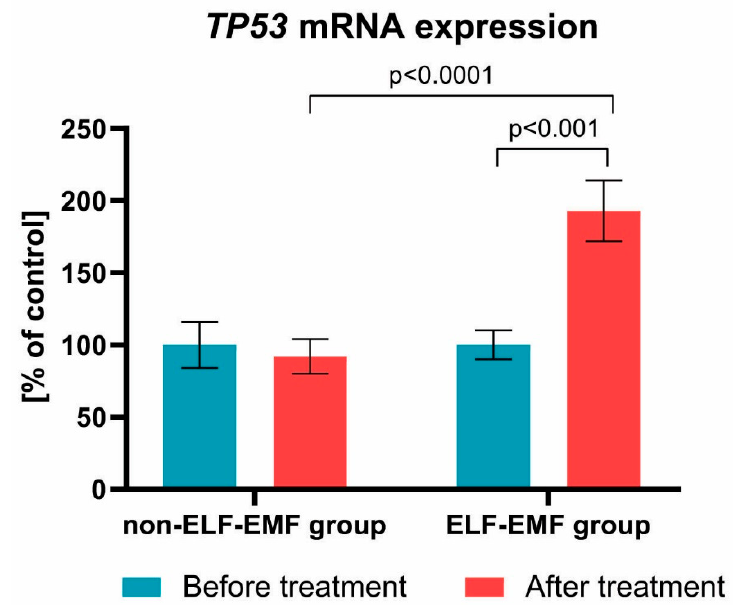
Figure 6. Comparison of the TP53 mRNA expression acquired from the ELF-EMF group vs. the non-ELF-EMF group. Results formulated as parameter changes before and after therapy (100% expressed for the level of TP53 mRNA expression in each patient sample before treatment). Statistical significance between ELF-EMF and non-ELF-EMF groups after 10 sessions amount to p < 0.0001.